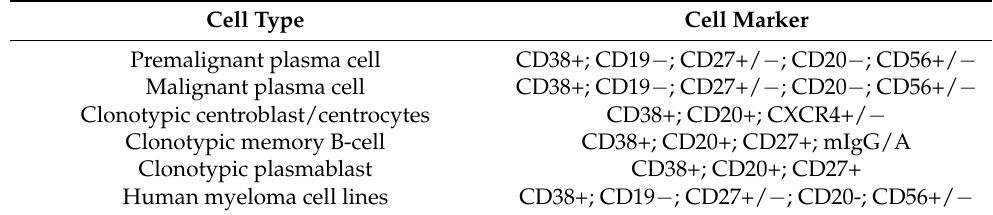
Table 1. Immunophenotype dissecting B-cell differentiation and myeloma